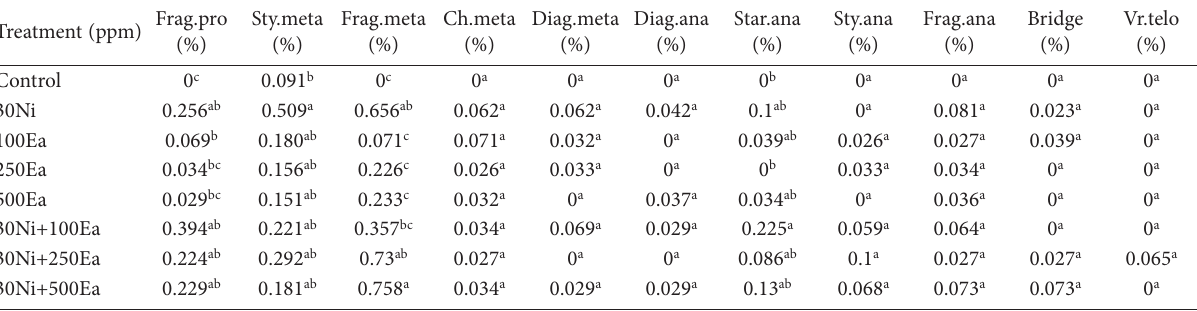
Table 3. The percentage of each type of chromosomal aberration of A. cepa root tip cells after treatment with Ni, encapsulated E. acoroides leaves extract and combined Ni and encapsulated extract.